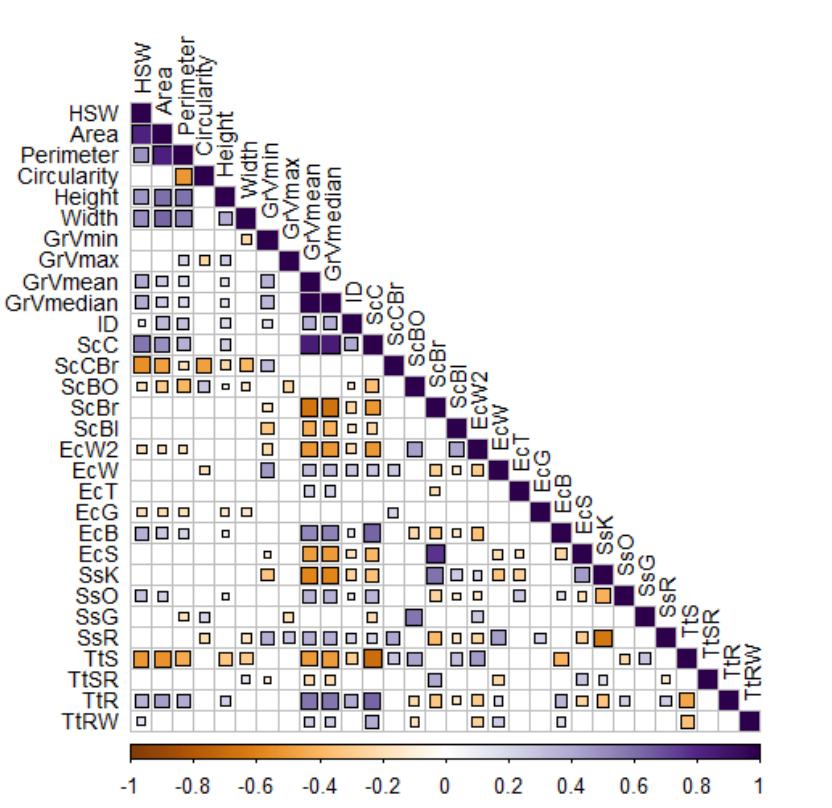
Figure 3. Pearson’s corrplot of the seed morphological traits. Non-significant correlations were omitted from the plot ( p > 0.05). Seed trait abbreviations are explained in the Abbreviations.